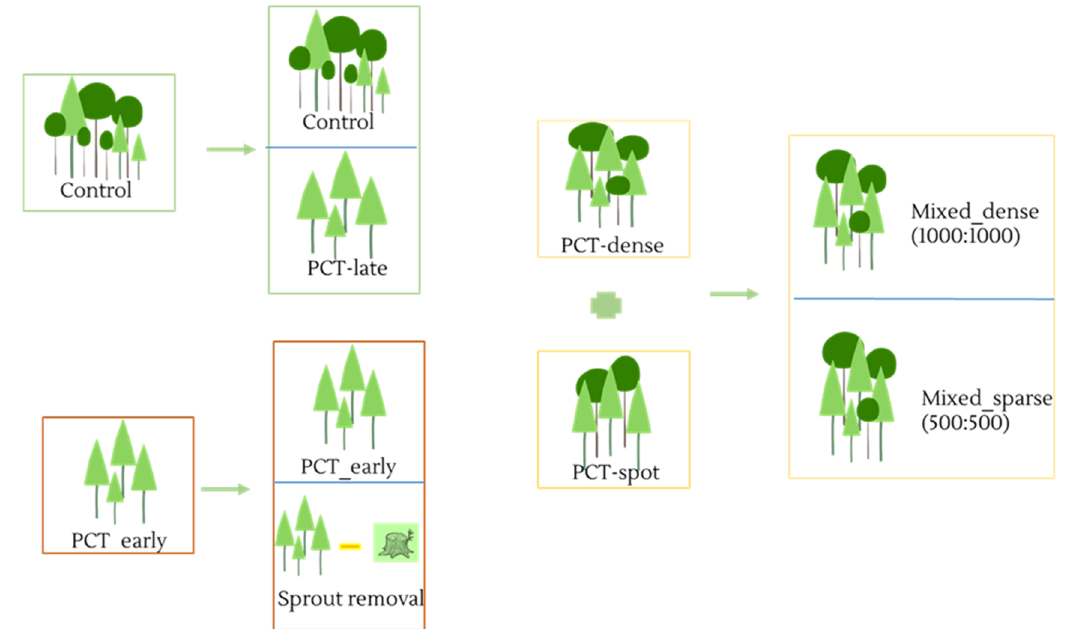
Figure 2. Treatments used in the 1st and 2nd pre-commercial thinnings. The same colour frame between 1st and 2nd PCT indicates that the new treatments in the 2nd PCT build on 1st PCT treat- ment.